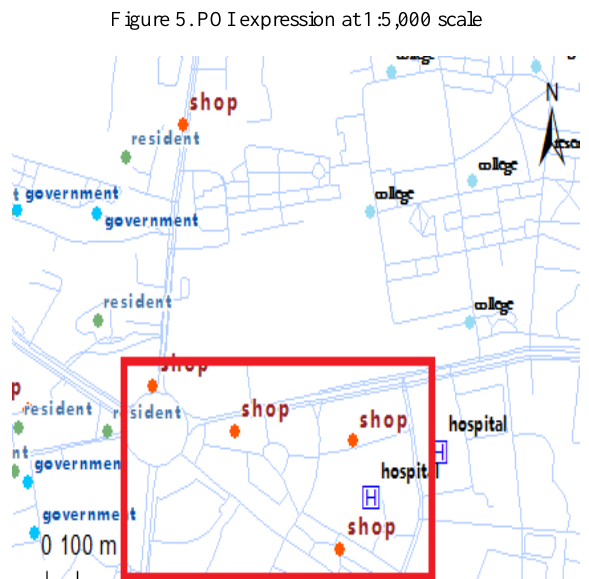
Figure 5. POI expression at 1:5,000 scale